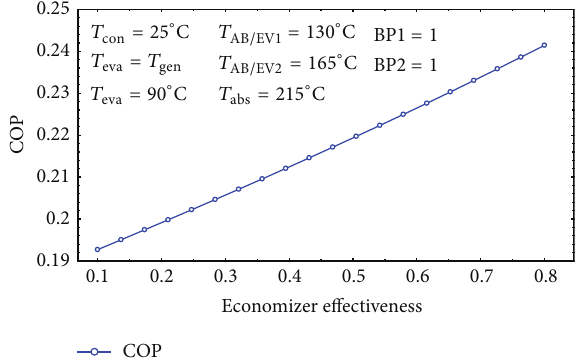
Figure 15: The effect of economizer on COP of the cycle.